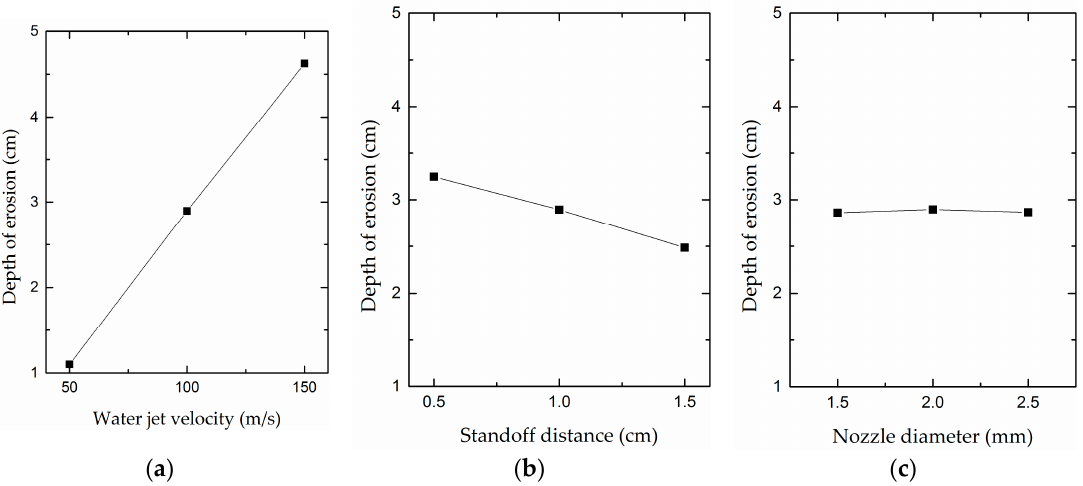
Figure 5. Trend chart of the erosion depth variation of HBS. ( a ) Water jet velocity; ( b ) standoff distance; ( c ) nozzle diameter.